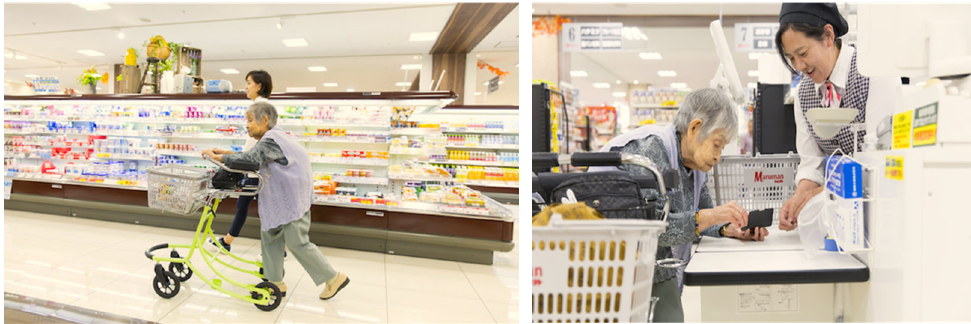
Figure 1. Shopping rehabilitation. Copyright © 2021 Hikari project Co., Ltd. All Rights Reserved.